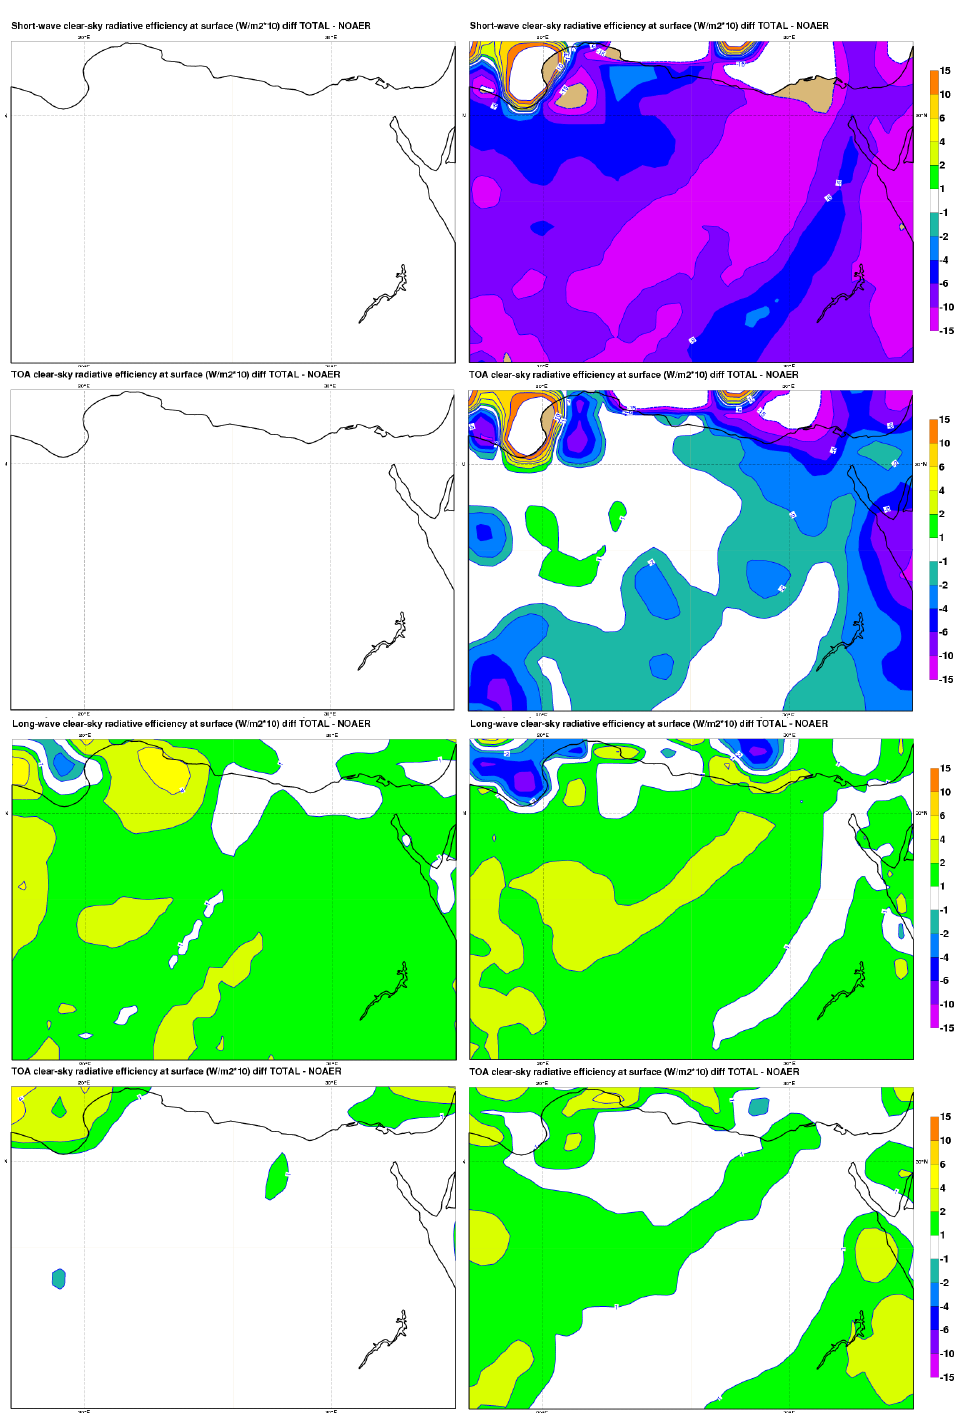
Figure 7. Simulations starting on 17 April 2012, 24h forecast (left) and 36h (right) forecast time. TOTAL experiment, clear-sky radiative efficiency (defined as the aerosol radiative effect per unit aerosol optical depth) for short-wave radiation fluxes at the surface (top) and TOA (middle top), for long-wave radiation fluxes at the surface (middle bottom) and TOA